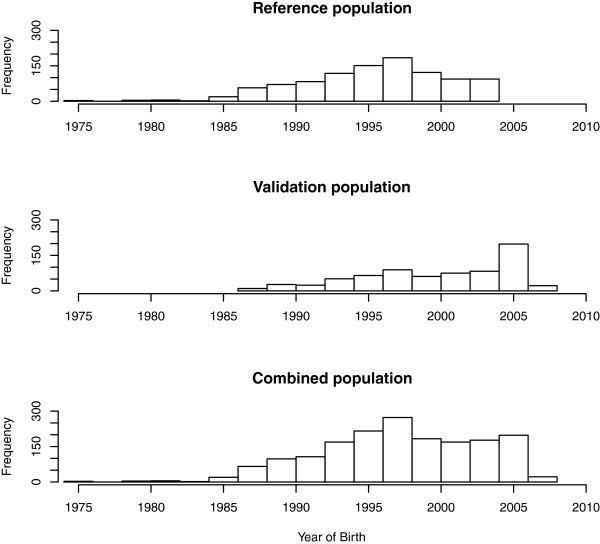
Distribution of birth-years of the individuals from three datasets.